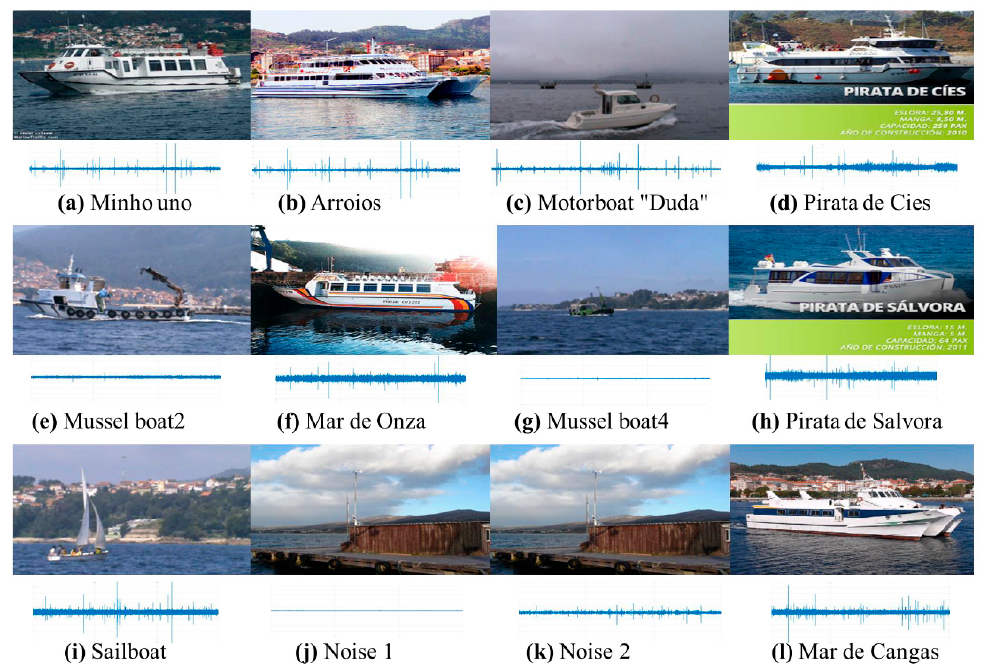
Figure 1. Selected 12 sound recordings: ( a ) Minho uno; ( b ) Arroios; ( c ) Motorboat “Duda”; ( d ) Pirata de Cies; ( e ) Mussel boat2; ( f ) Mar de Onza; ( g ) Mussel boat4; ( h ) Pirata de Salvora; ( i ) Sailboat; ( j ) Noise 1; ( k ) Noise 2; ( l ) Mar de Cangas.